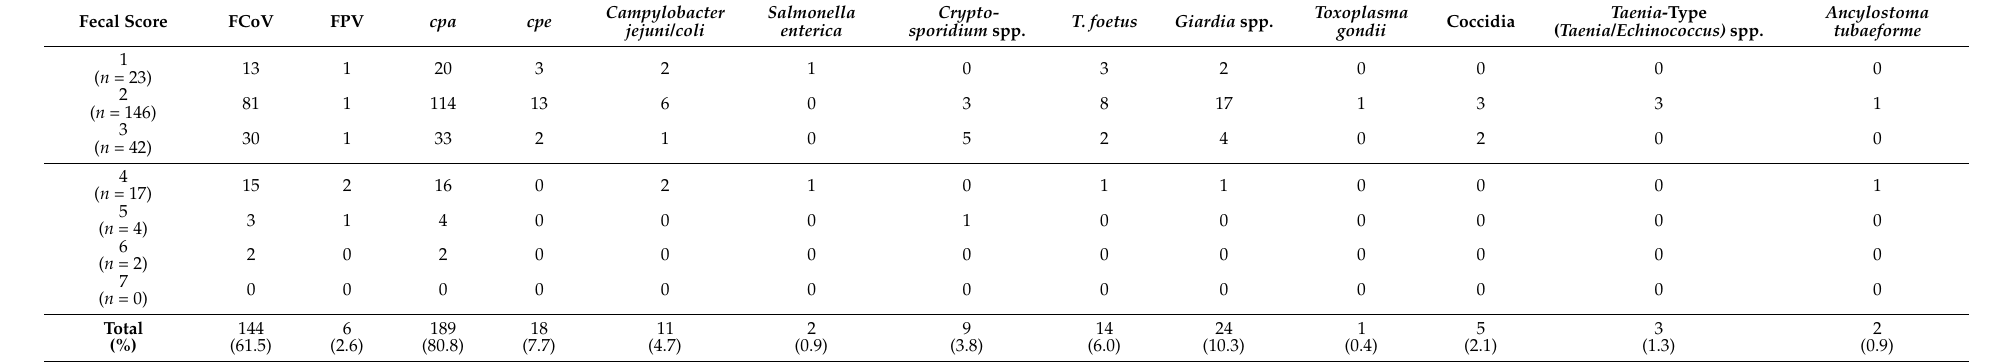
Table 3. Number of cats positive for feline coronavirus (FCoV) and other potential enteropathogens grouped by fecal score.